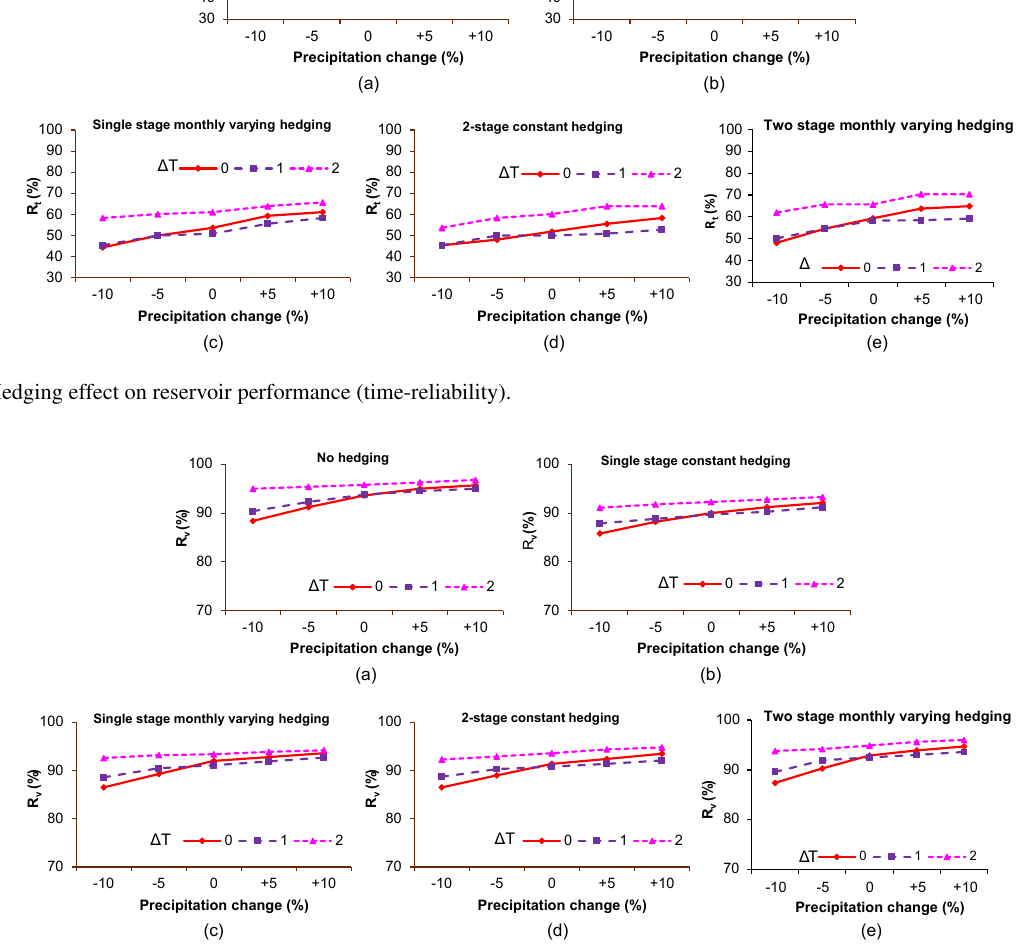
Figure 8. Hedging effect on reservoir performance